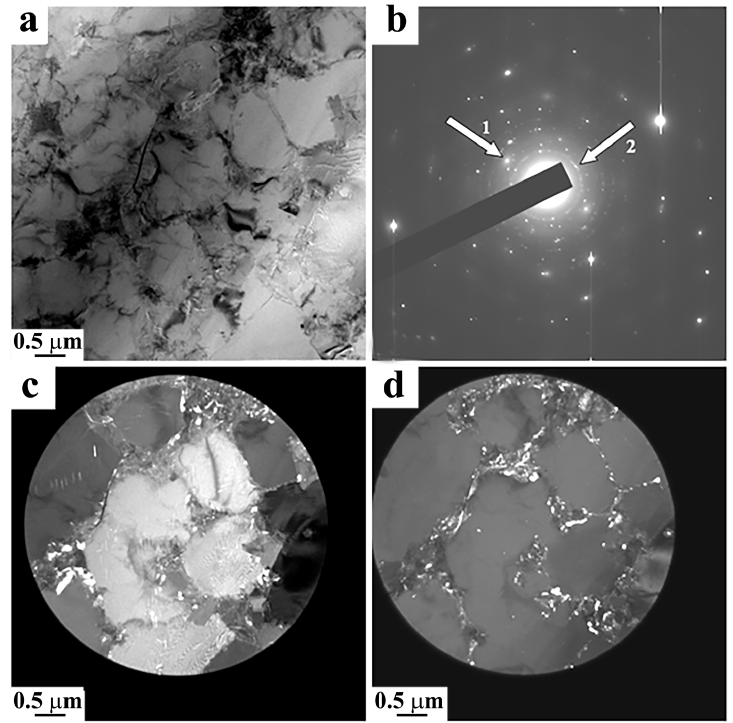
Figure 6. Electron microscopic image of cellular crystallization structure of Al-11wt%Si alloy’s surface layer subjected to electroexplosion alloying and subsequent irradiation by intense pulsed electron beam; a– bright field; b - selected area electron diffraction (the arrows designate the reflections of dark field formation: 1 - c, 2 - d; c, d - dark fields formed in reflections [111] Al (c) and [111] Si (d),